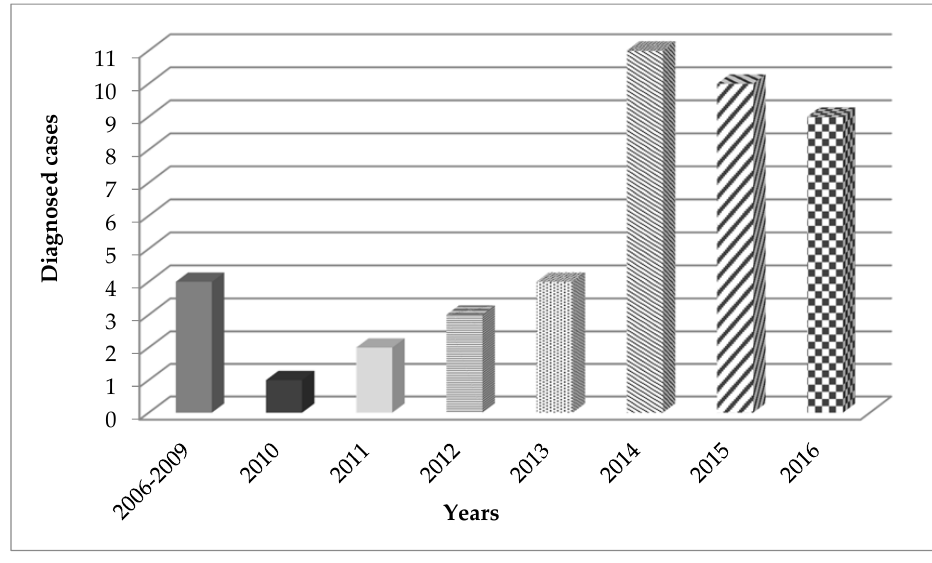
Figure 1. Cases frequency by year.